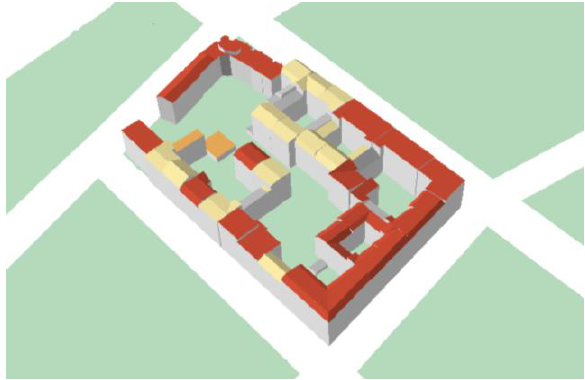
Figure 5. Statistical blocks with integrated building